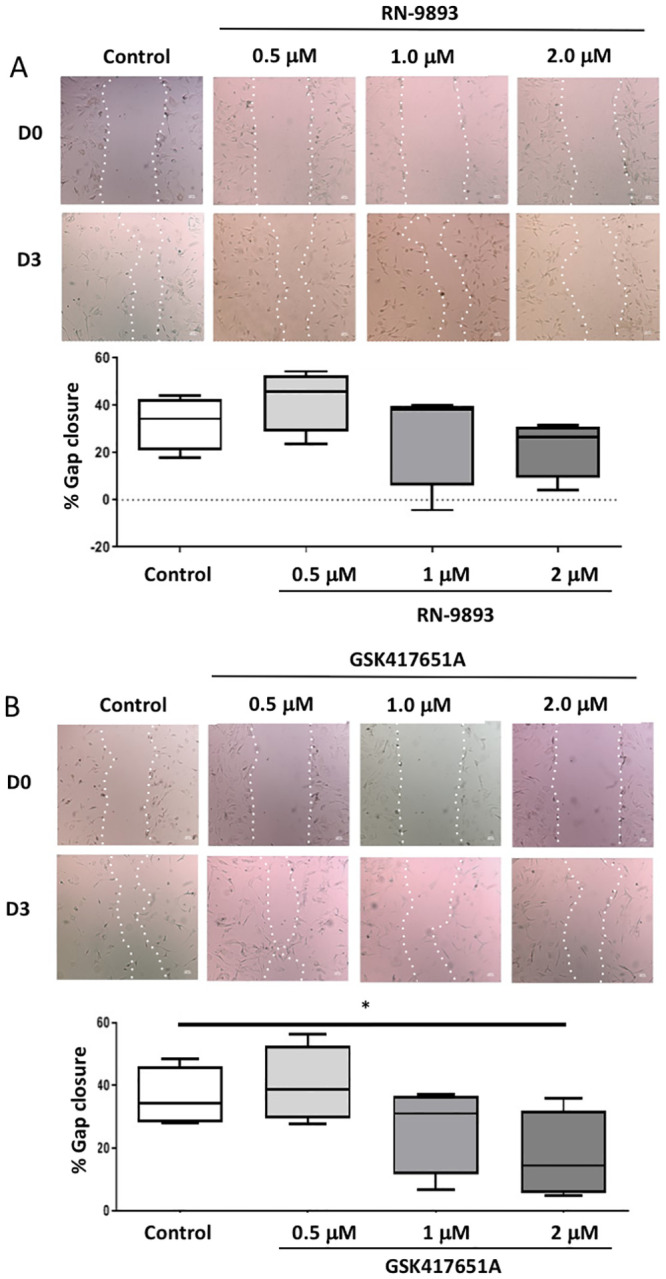
Effect of inhibitors of TRPV4 and TRPC6/3 on VICFB migration in a cell-culture scratch assay.Phase-contrast microscopy image of scratch assays, showing VICFB and scratch edge at Day-0 (top row) and Day-3 (bottom row) in the absence (control) and presence of different concentrations of (A) the TRPV4 inhibitor RN-9883 and (B) the TRPC6/3 inhibitor GSK417651A. Scratch edge in each panel is indicated by the white dotted-line. Quantification of migration (day 3) as a function of different concentrations of RN-9883 and GSK417651A is shown in the lower panels of A and B, respectively (n = 6 patients; * = p<0.05).